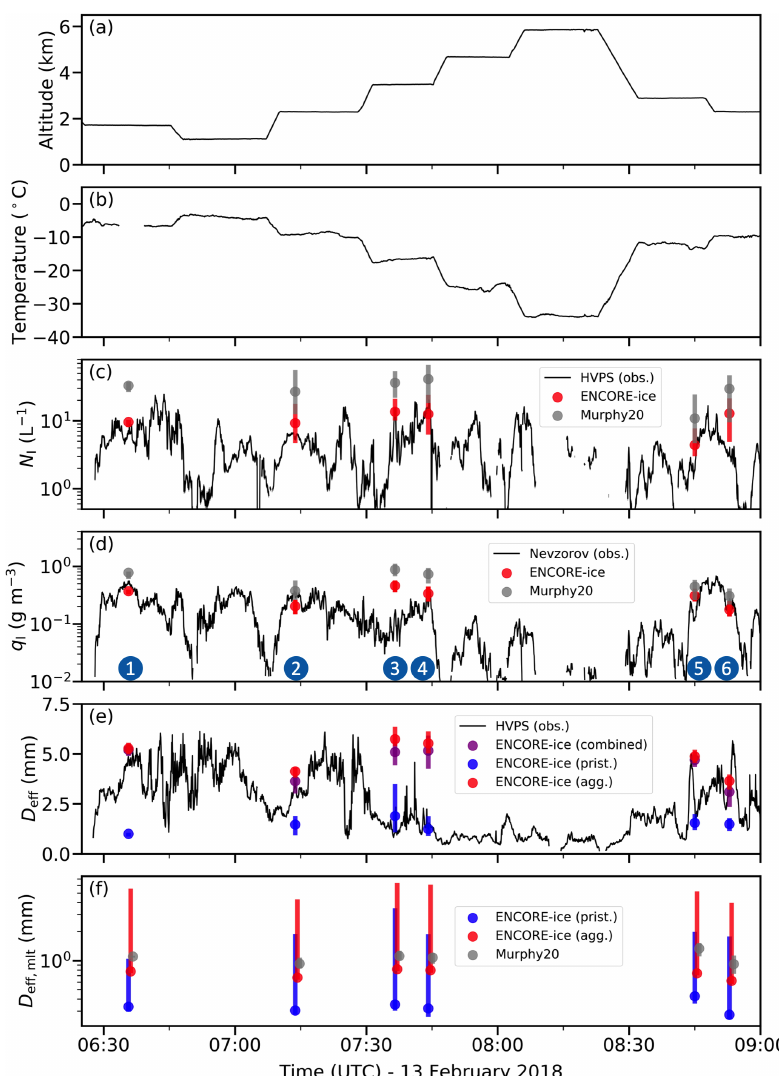
Figure 9. Time series of (a) flight altitude; (b) temperature; and observed and retrieved (c) total ice number concentration, (d) ice water content, (e) effective mean diameter using the maximum particle dimension as the size descriptor, and (f) effective mean diameter using the equivalent melted diameter as the size descriptor. Retrievals from ENCORE-ice and Murphy20 empirical relationships are denoted by dots, explained by detailed legends. The dots represent the median of retrievals from all collocated gates, and the vertical bars denote the range between the 25th and 75th percentiles. Note that the counting uncertainty in the total ice number concentration in (c) is plotted but too small to see. All calculations are based on the size range of HVPS observations, except Murphy20 retrievals in (c) and (d) . For convenience, we index six retrieval clusters from 1 to 6 as shown in (d)